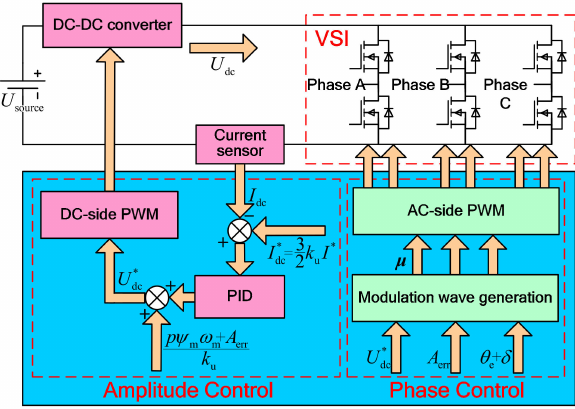
Figure 5. Schematic diagram of the proposed